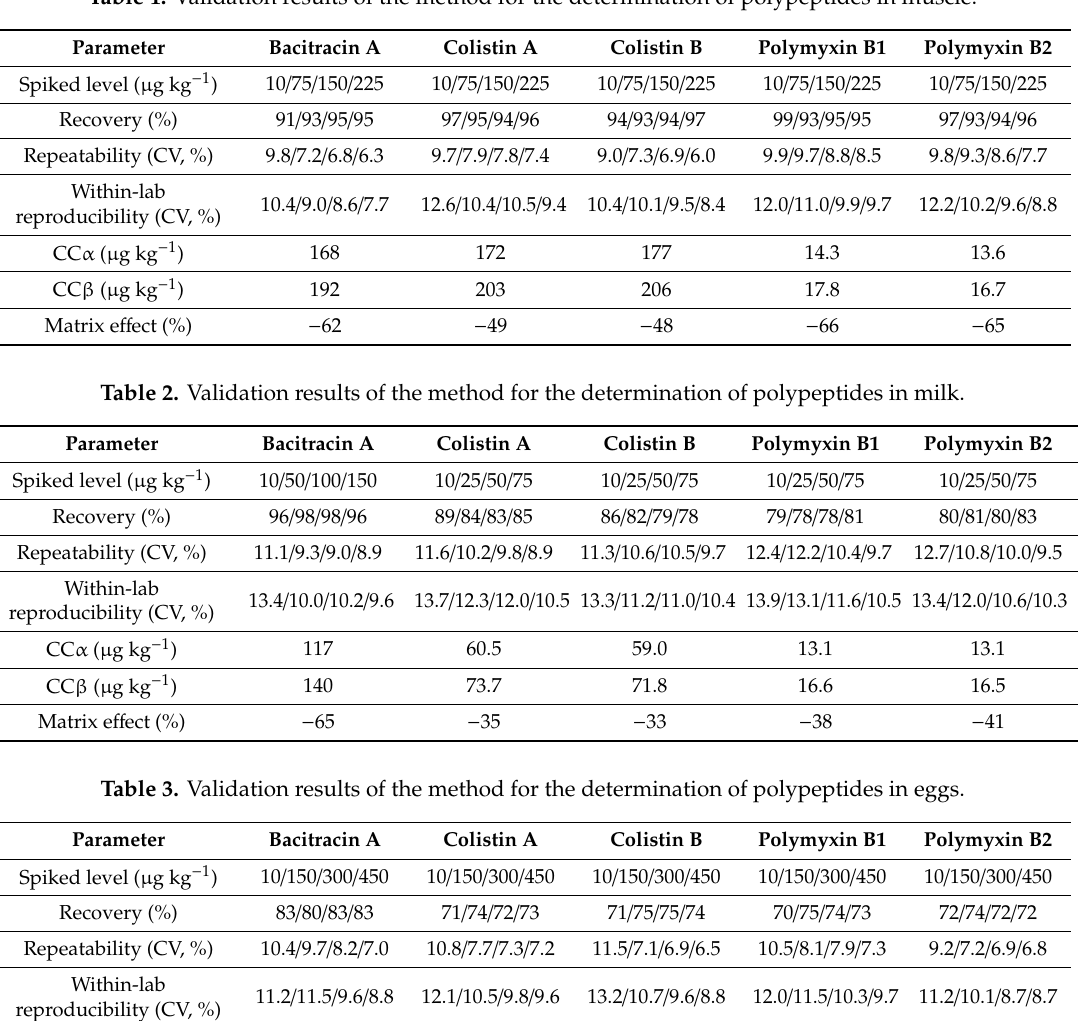
Table 1. Validation results of the method for the determination of polypeptides in muscle.